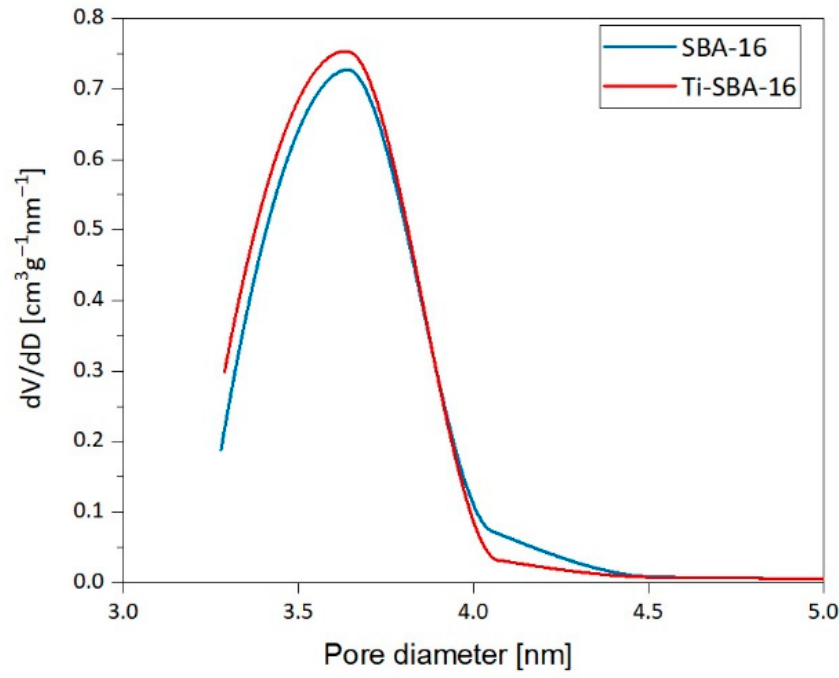
Figure 4. Cage diameter distribution calculated by the Barrett–Joyner–Halenda (BJH) method from